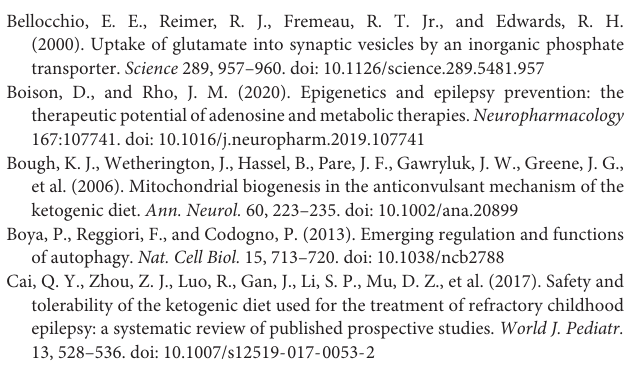
Supplementary Figure 1 | GO functional enrichment analysis of differentially abundant proteins. Supplementary Figure 2 | KEGG pathway enrichment analysis of proteins differing in abundance between SE + KD and Ctr groups. Supplementary Figure 3 | Distribution of fragment ion peak area: LAAESSSSQPTQQR (corresponding protein accession D4A772). Supplementary Figure 4 | Distribution of fragment ion peak area: ASNQSQPLER (corresponding protein accession Q5BK47). Supplementary Figure 5 | Distribution of fragment ion peak area: SGASGGLSGGESR (corresponding protein accession D4A9A3). Supplementary Figure 6 | Distribution of fragment ion peak area: SNPGGFGIAPHCLDEGTVR (corresponding protein accession D4A9A3). Supplementary Figure 7 | Distribution of fragment ion peak area: GGDGSPGGAGATAAR (corresponding protein accession Q5XIU9). Supplementary Figure 8 | Distribution of fragment ion peak area: DFSLEQLR (corresponding protein accession Q5XIU9). Supplementary Figure 9 | Distribution of fragment ion peak area: ESSEQVQPTCPK (corresponding protein accession Q9JJW1). Supplementary Table 1 | Differential abundance of proteins among Ctr, SE, and SE + KD groups. Supplementary Table 2 | Optimized differential abundance of proteins. Supplementary Table 3 | KEGG pathway enrichment analysis of proteins differing in abundance between SE and Ctr